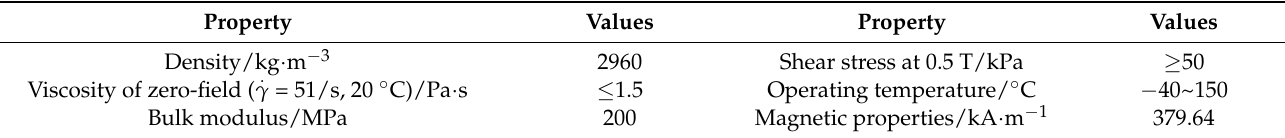
Table 1. Parameters of MRF-G28.